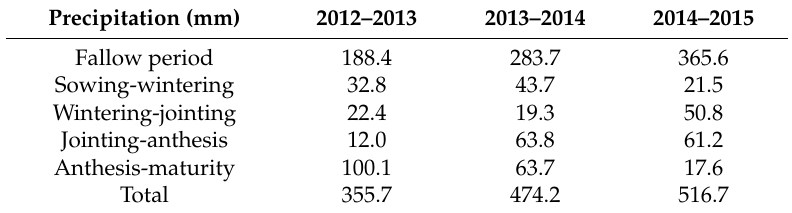
Table 1. Precipitation distribution of the experimental site from 2009–2015, during the fallow season and the growth stages of winter wheat (Source: Meteorological Observation of Wenxi County, Shanxi Province,